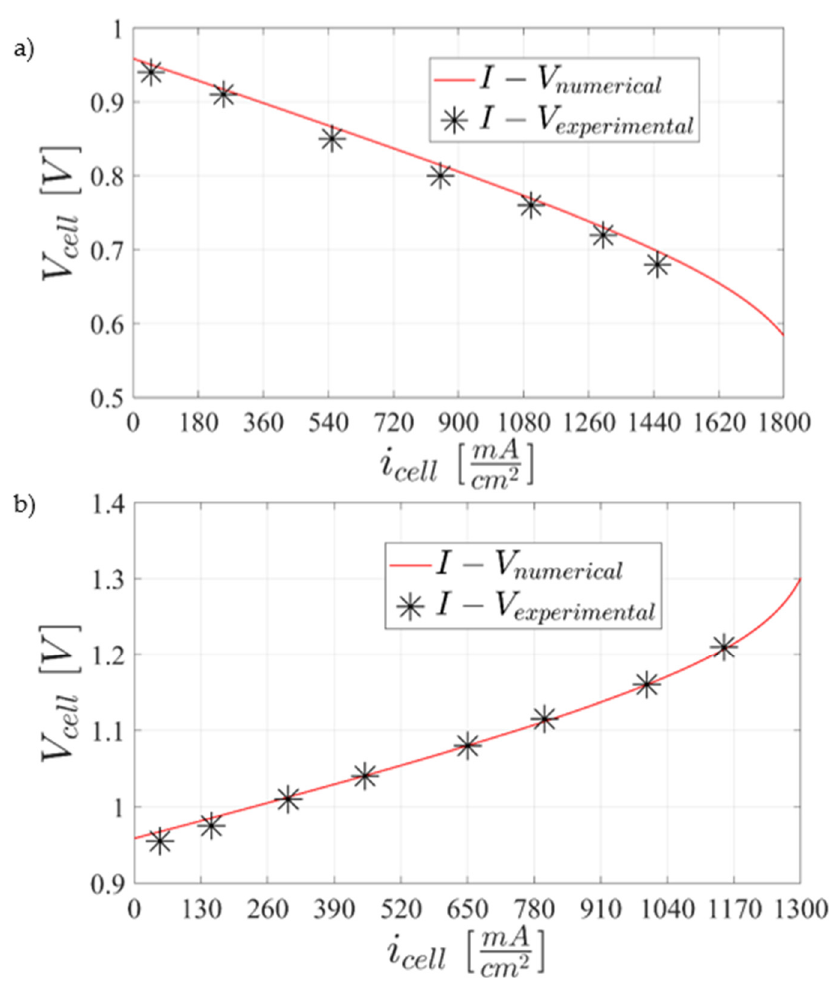
Figure 5. Comparison between numerical and experimental data for the fuel cell mode ( a ) and the electrolyzer mode ( b ).